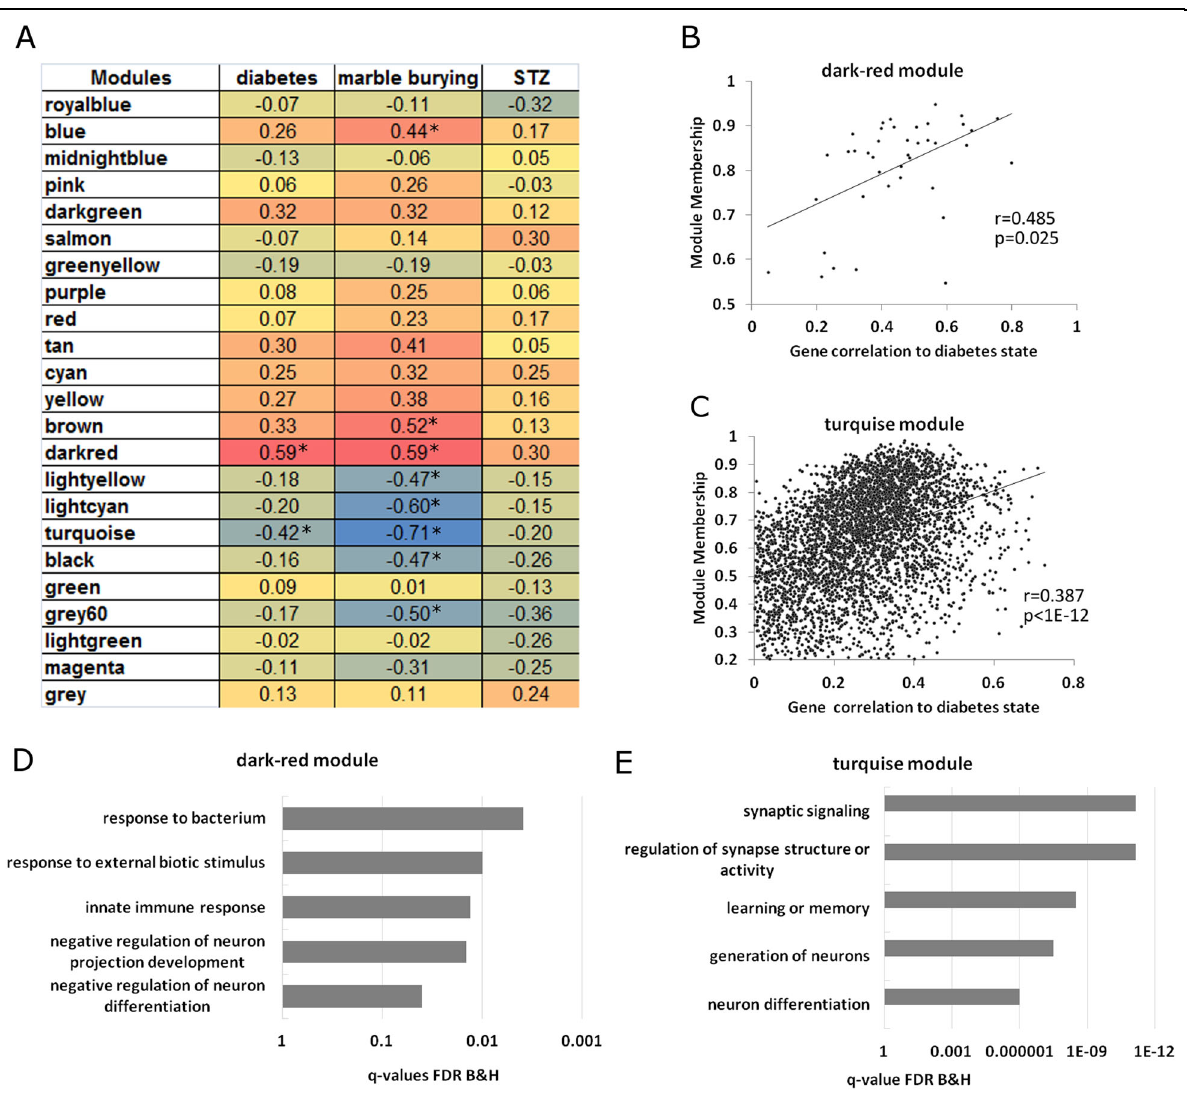
Fig. 5 Effects of gestational diabetes on striatal gene transcription. A WGCNA analysis of striatal RNA-seq data. Modules were correlated to maternal diabetes (STZ + D group), amount of marbles buried, and STZ treatment. B , C Scatter plots indicate the correlation (Pearson ’ s r correlation coef fi cient) and its signi fi cance ( p value) between module membership and gene signi fi cance (gene correlation to diabetes state). The positive correlation gives further evidence that genes in these modules are associated with the state of gestational diabetes in the mother. D , E Gene ontology analysis of genes in the dark-red and turquoise